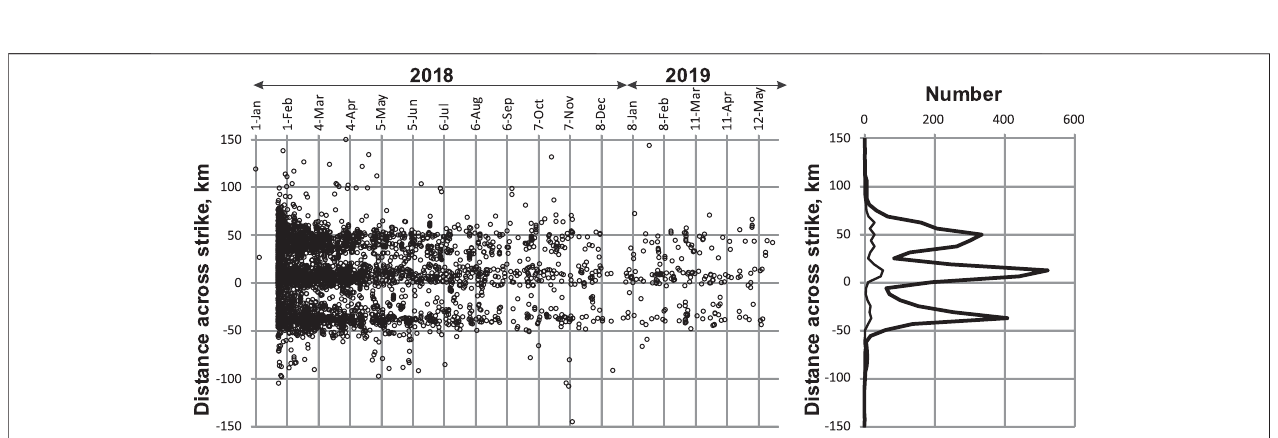
FIGURE9| Modelingthe January 23, 2018,M W 7.9 earthquake: (A) stations used todetermine parametersoftheearthquake inthedoublecouple approximation, (B) source depth residual function, (C) focal mechanism, (D) the earthquake focal model, e) one-dimensional bilateral model of faulting oriented along the centroid velocity. Notes: the same as in Figure 8 .